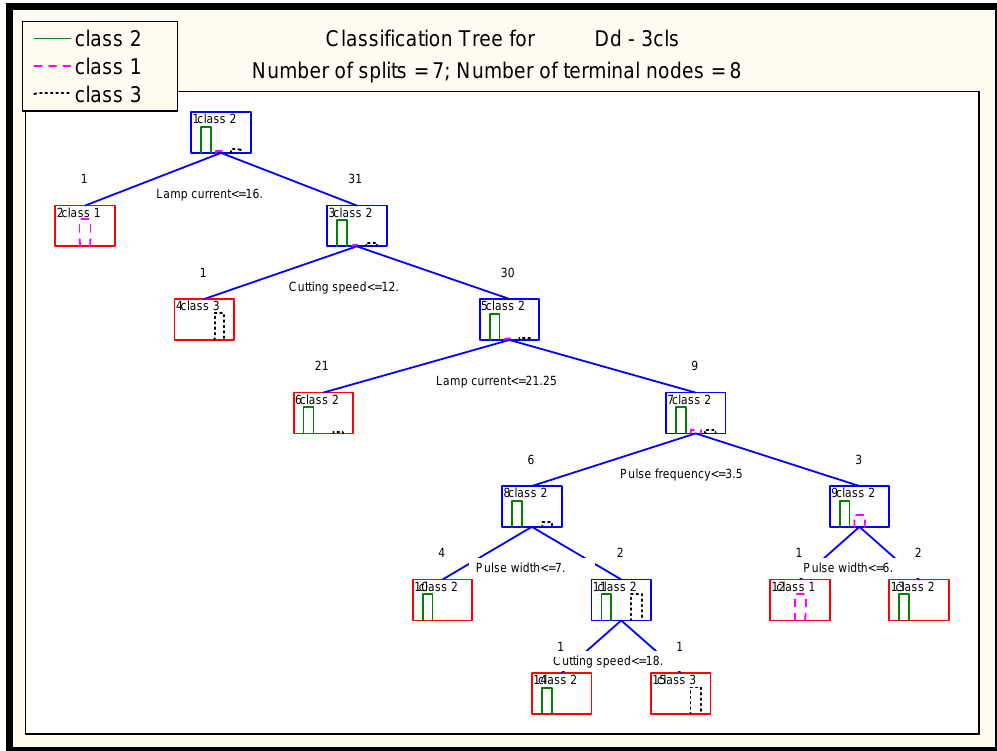
Fig. 13. Decision tree for deviation of depth (three classes)